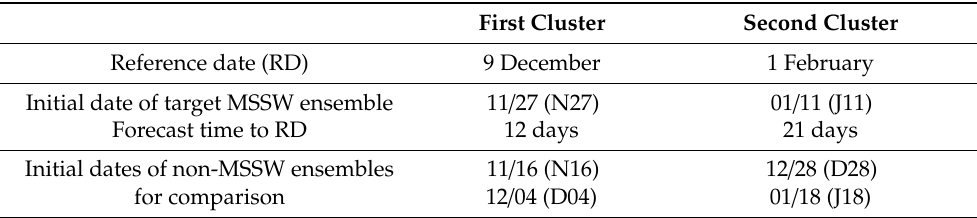
Figure 2. Number of ensemble members that show a first reversal of the zonal mean zonal wind at 60 ◦ N, 10 hPa on each forecast day and calendar date. Di ff erent colors are used to emphasize di ff erences in the numbers. Each slope corresponds to an ensemble set for the same initial time. Table 1. Initial dates of ensembles analyzed for two clusters in this study. The initial dates are given in mm / dd format. MSSW, major sudden stratospheric